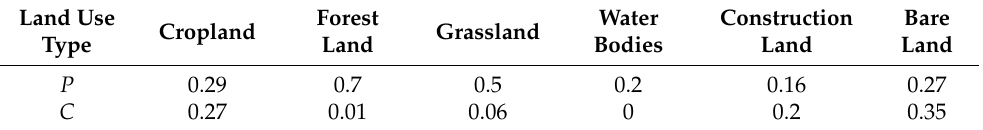
Table 1. P and C values of different land use